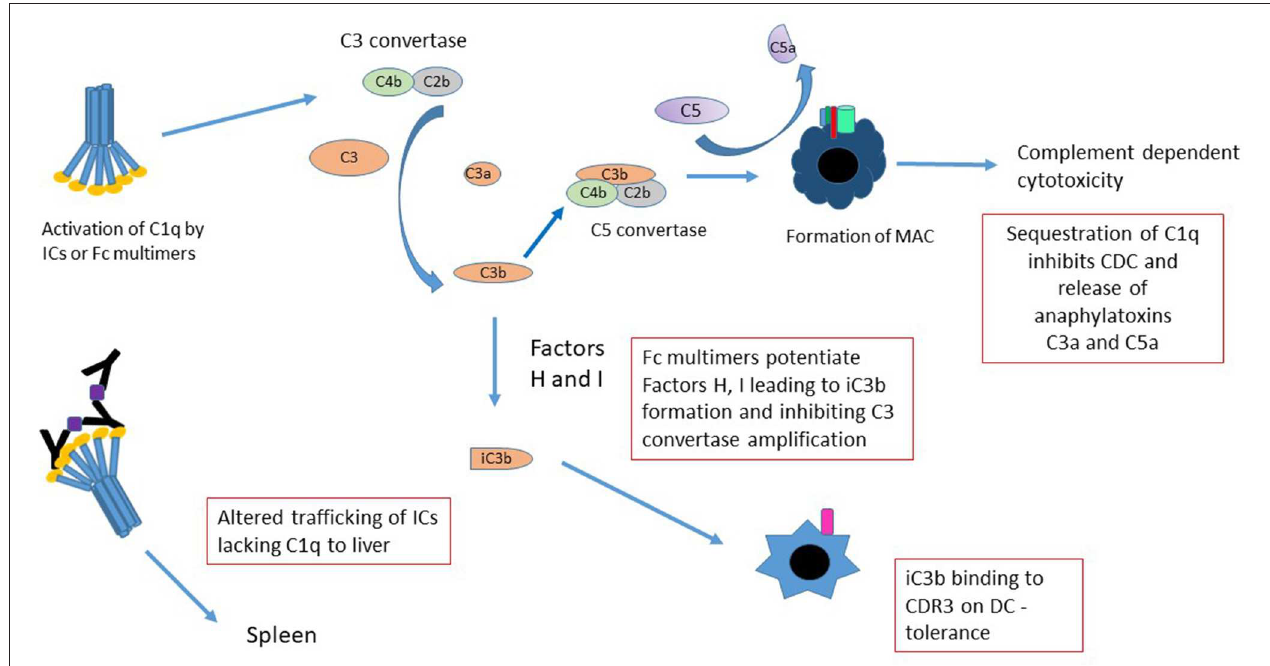
FIGURE 3 | Mechanisms of Fc multimer inhibition of complement function. There are several mechanisms by which Fc multimers may inhibit complement functions. Sequestration of C1q by multimers prevents pathogenic IC-induced CDC, release of anaphylatoxins C3a and C5a and redirects trafficking of C1q-bearing ICs from the spleen to the liver. Activation of complement by Fc multimers leads to limited production of C3 convertase and in the presence of Factor H and I degrades C3b to iC3b (75) inhibiting the C3 convertase amplification loop and potentially increasing iC3b binding to CD3 on DCs inducing